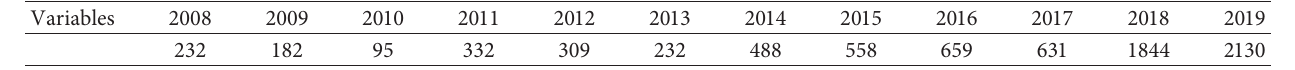
Table 1: Number of high-tech enterprises identified in Nanjing from 2008 to